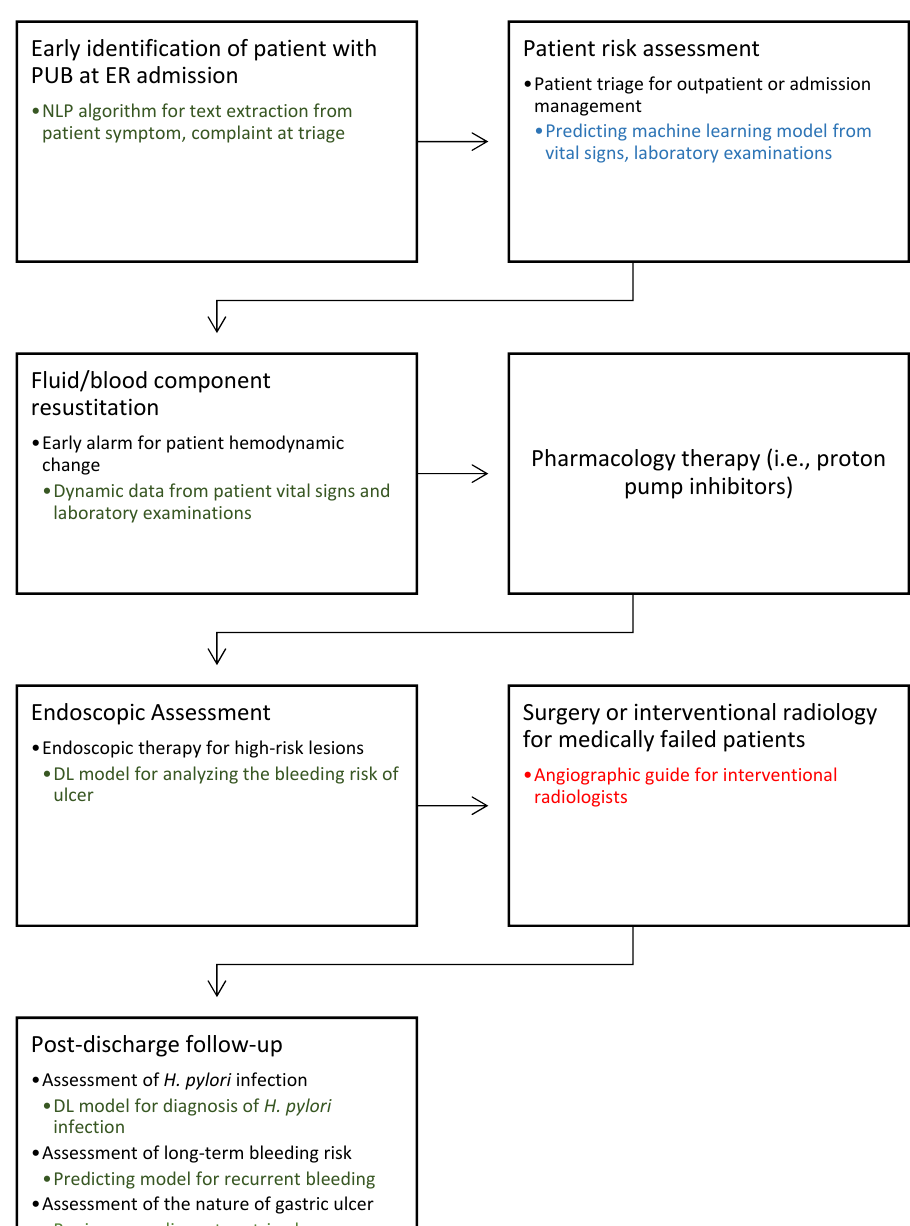
Figure 1. Cascade management of peptic ulcer bleeding. This diagram illustrates the potential role of artificial intelligence (AI) in the future management of peptic ulcer bleeding (PUB) based on text, data, and imaging. Blue: studies with multicenter clinical data validation; Green: studies with single-center clinical data validation; Red: no relevant research found in this field. AI, artificial intelligence; DL, deep learning; ER, emergency room; NLP, natural language processing; PUB, peptic ulcer bleeding.